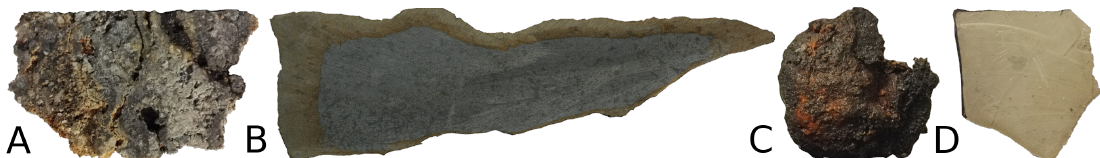
Figure 1. The samples used in the experiment, representing variations in mineralised material and in potential host rocks: ( A ) low-grade SMS; ( B ) basalt; ( C ) high-grade submerged massive sulphide (SMS); and ( D ) mudstone. Samples B and C are investigated from multiple sides.